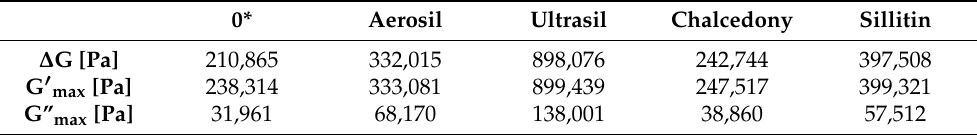
Table 4. Payne effect of unfilled and filled CR/BR/nano-Fe 2 O 3 vulcanizates.